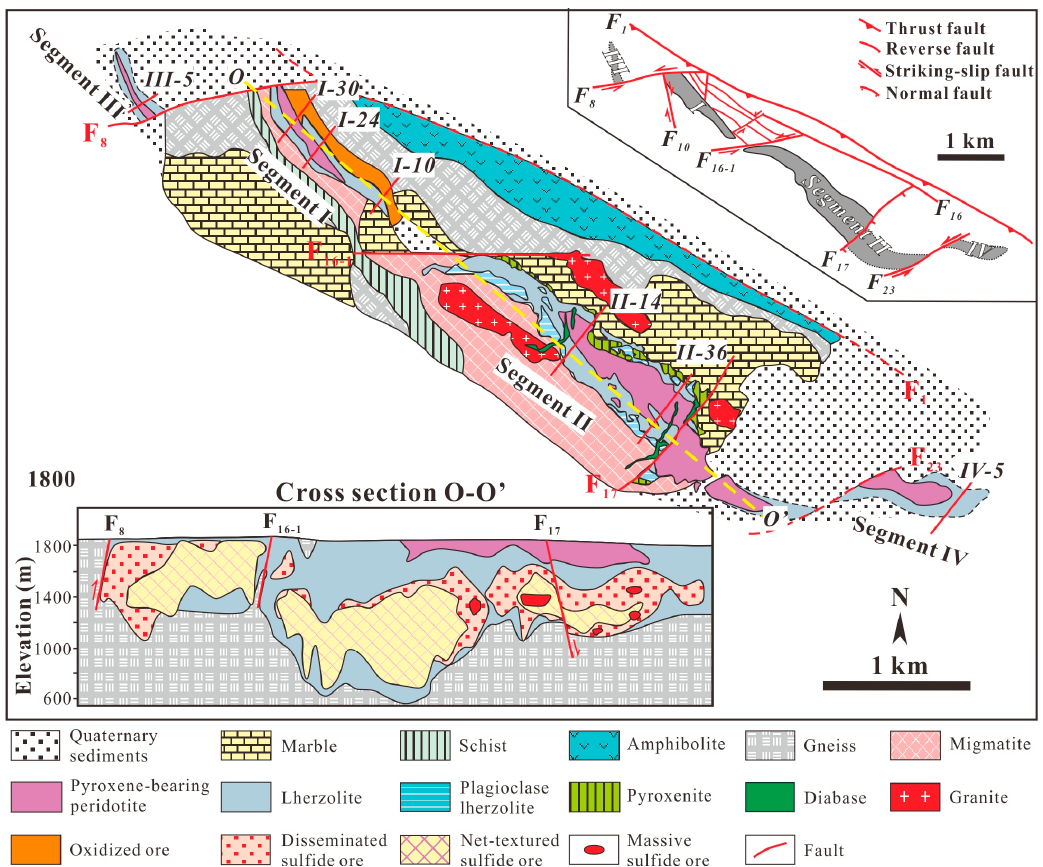
Figure 2. Geological map of the Jinchuan Ni-Cu-PGE deposit (modified after [35] and references therein).